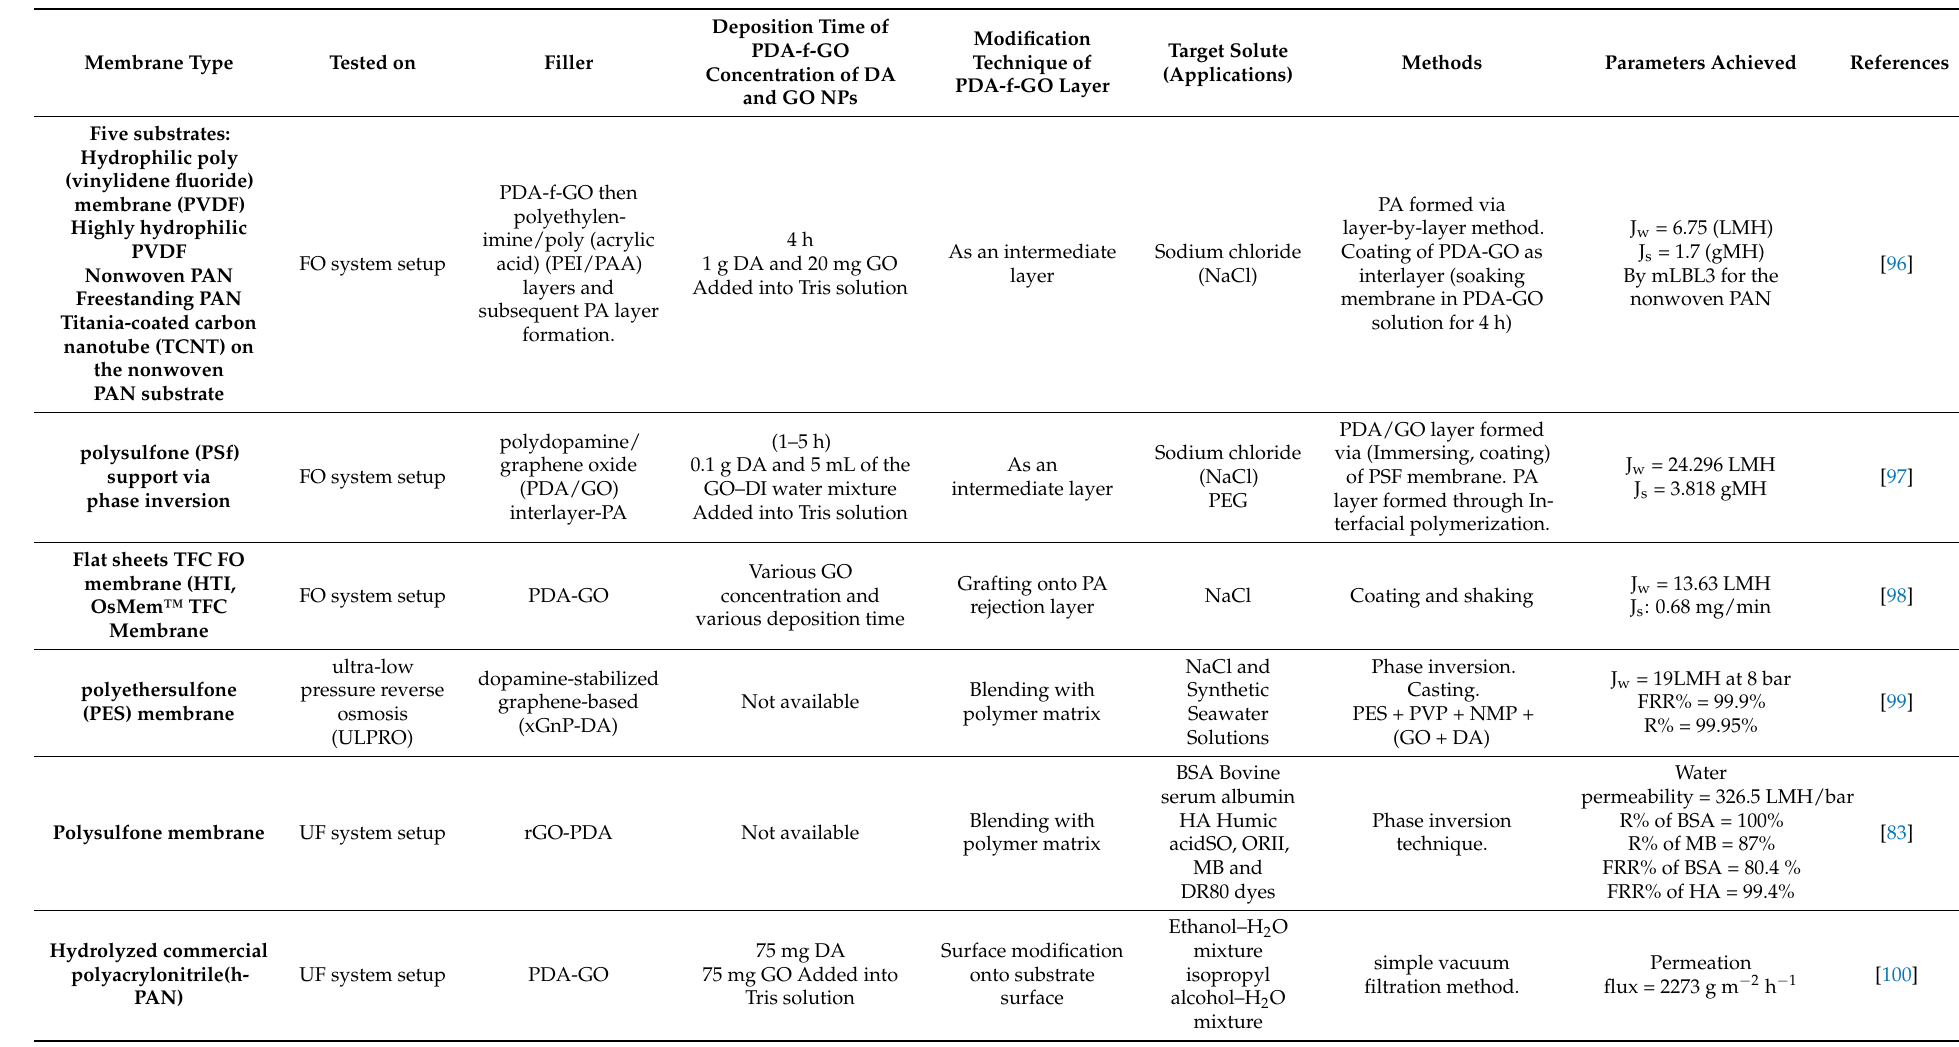
Table 5. Studies based on different membrane’s modifications techniques based on dopamine-functionalized GO